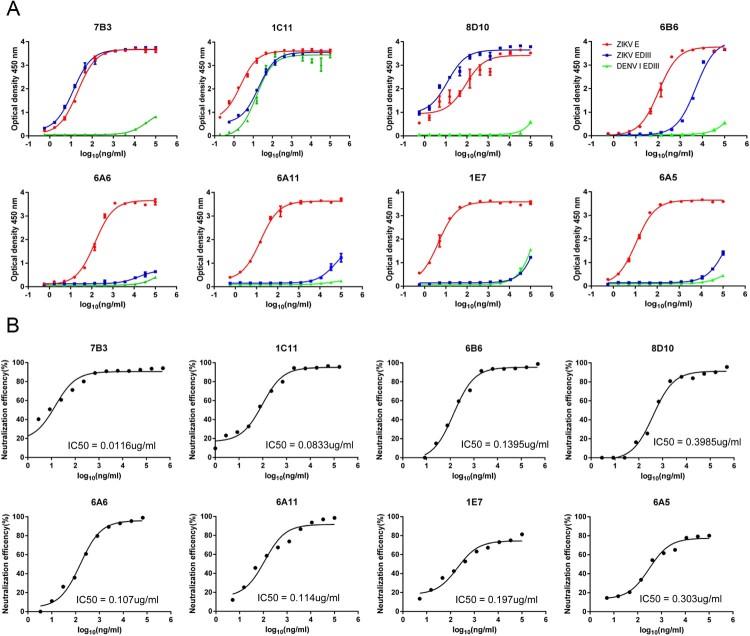
Binding and neutralization activities of representative E-targeted mAbs. (A) Binding activities of E-targeted mAbs to ZIKV E, EDIII, and DENV1 EDIII protein. (B) Neutralizing activity of E-targeted mAbs against ZIKV GZ02 strain. Serial dilutions of mAbs were tested for neutralizing activity against ZIKV GZ02 using a FACS-based neutralization test (FNT). Data are representative of two independent experiments.